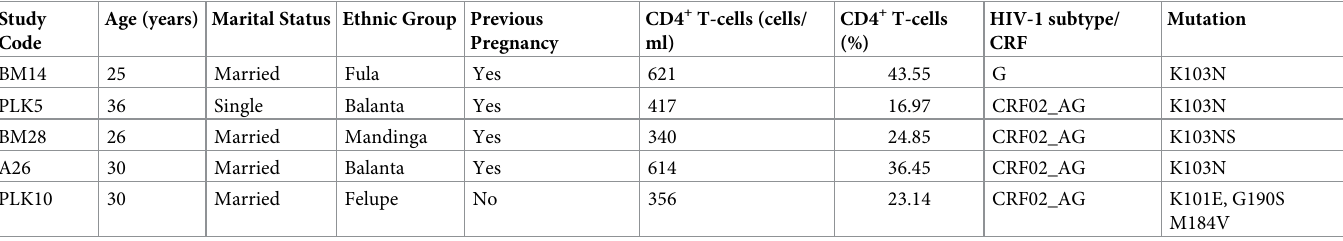
Table 2. Study participants with pretreatment drug resistance.